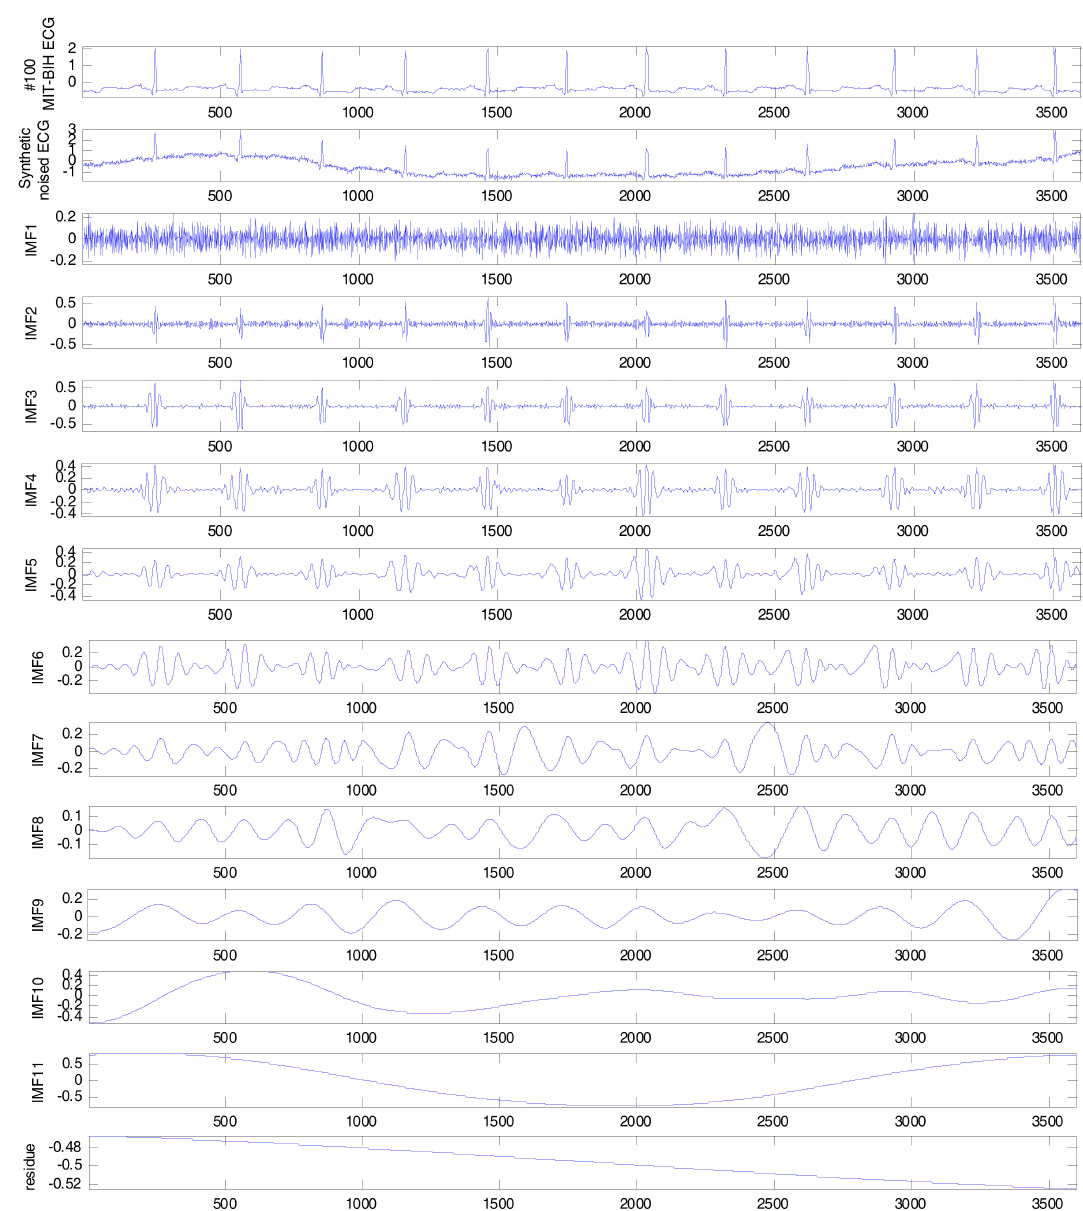
Figure 3. Synthetic noisy ECG signal and its intrinsic mode functions (IMFs) decomposed by complete ensemble empirical mode decomposition with adaptive noise